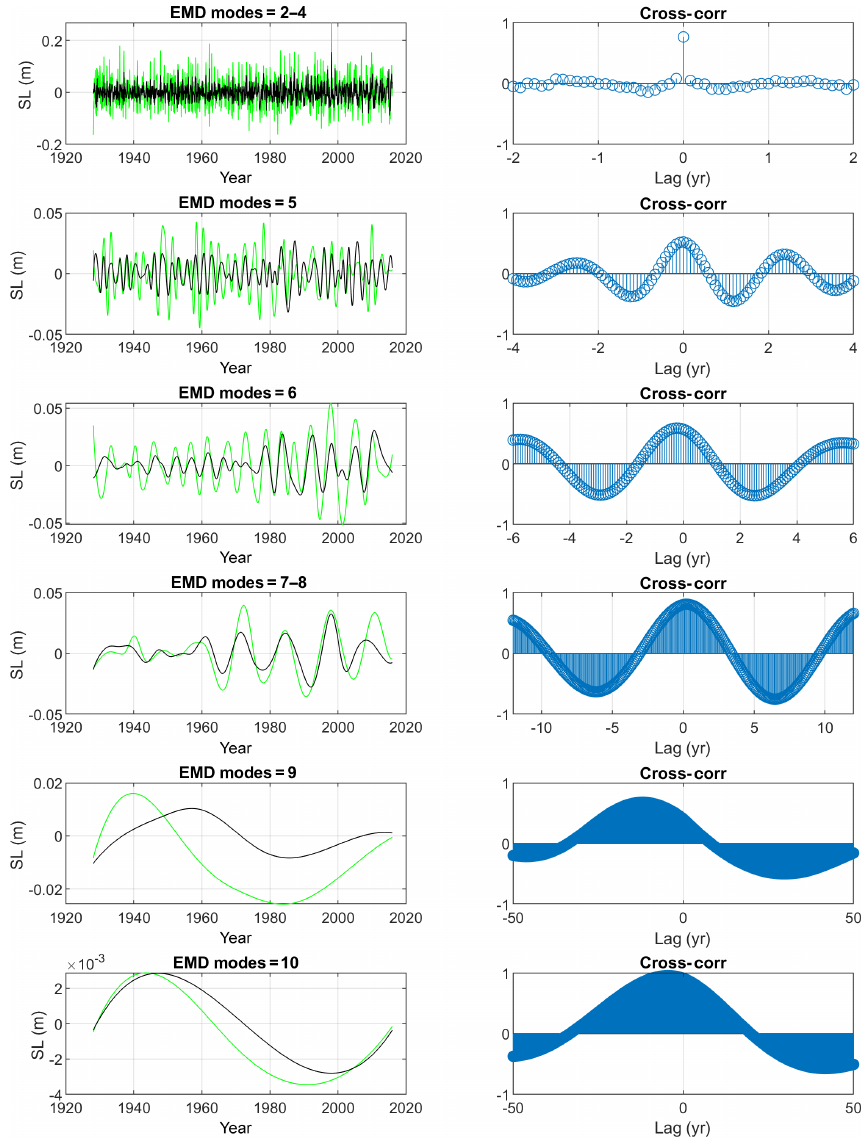
Figure 5. (left) EMD oscillating modes of the observed Norfolk sea level (green) and the reconstructed sea level (black). (right) Cross- correlation as a function of lag. High- to low-frequency modes are from top to bottom